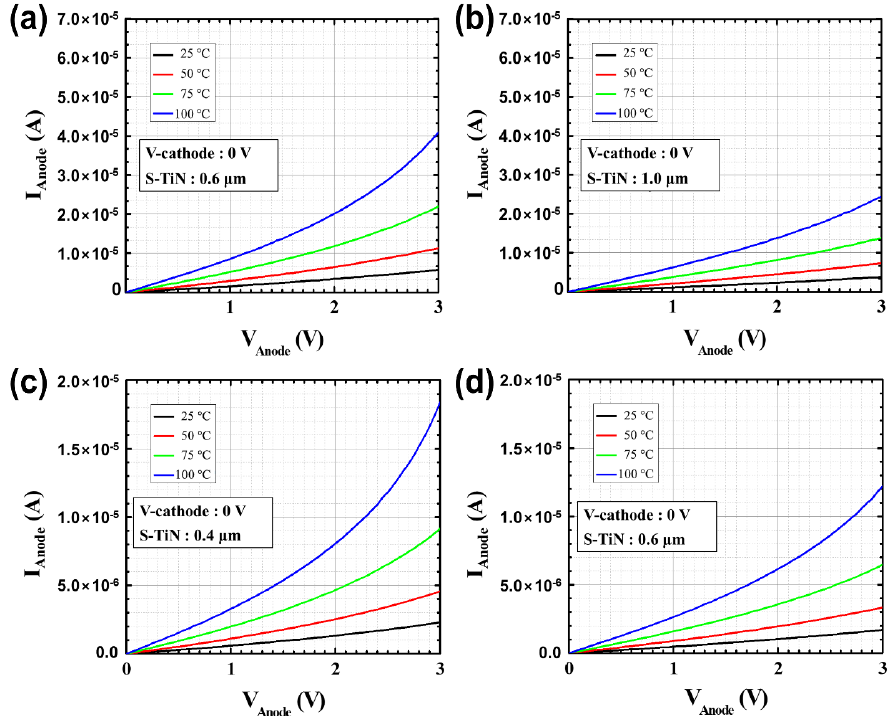
Figure 4. Measured DC characteristics according to the temperature (25, 50, 75, and 100 °C) of the four types of a-Si microbolometers: ( a ) P35-S06, ( b ) P35-S10, ( c ) P12-S04, and ( d ) P12-S06. Here, S-TiN stands for the pattern spacing of TiN layer.